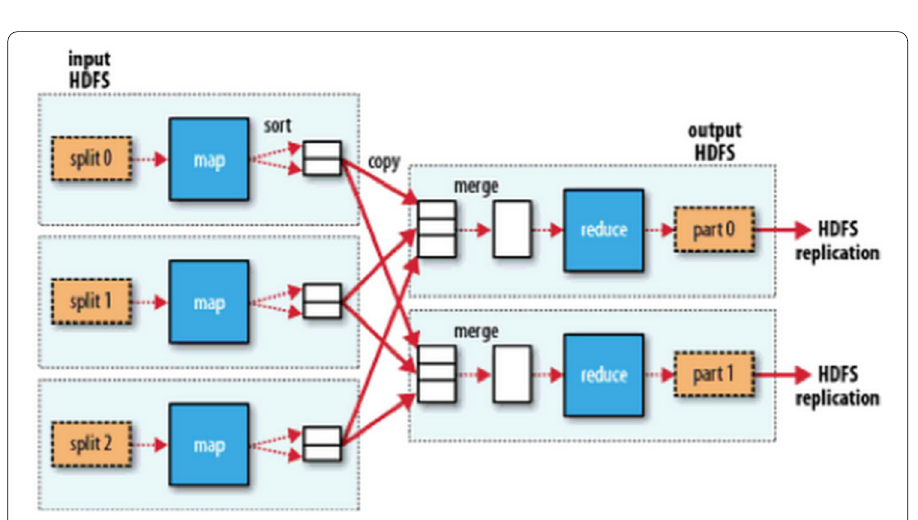
Fig. 6 The MapReduce Data Flow